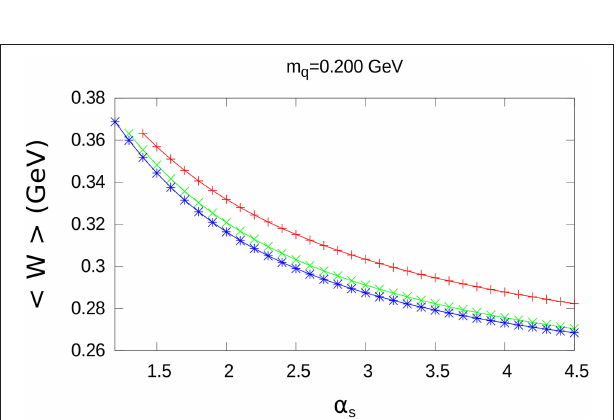
FIGURE A2 | Value of W as a function of α s . The same conventions as in the previous figures are